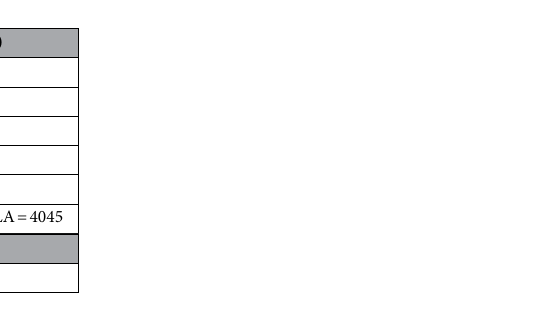
Table 2. Mass balance, and ELA changes of the Hoksar